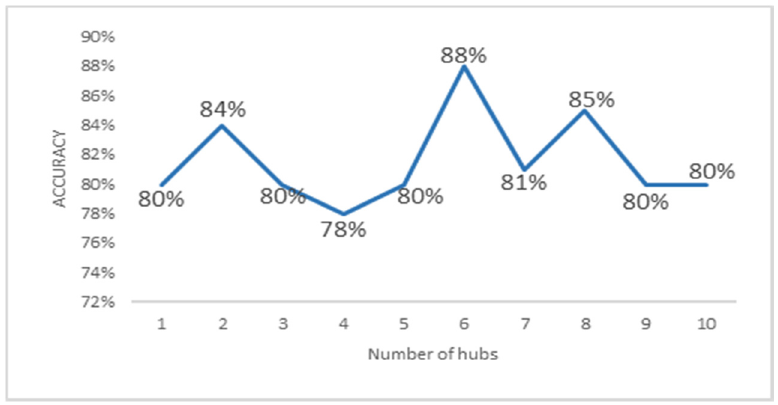
Figure 6. Accuracy of GraphChrom with integrated intra-/interchromosomal aberrations with different numbers of hubs in the GNN.